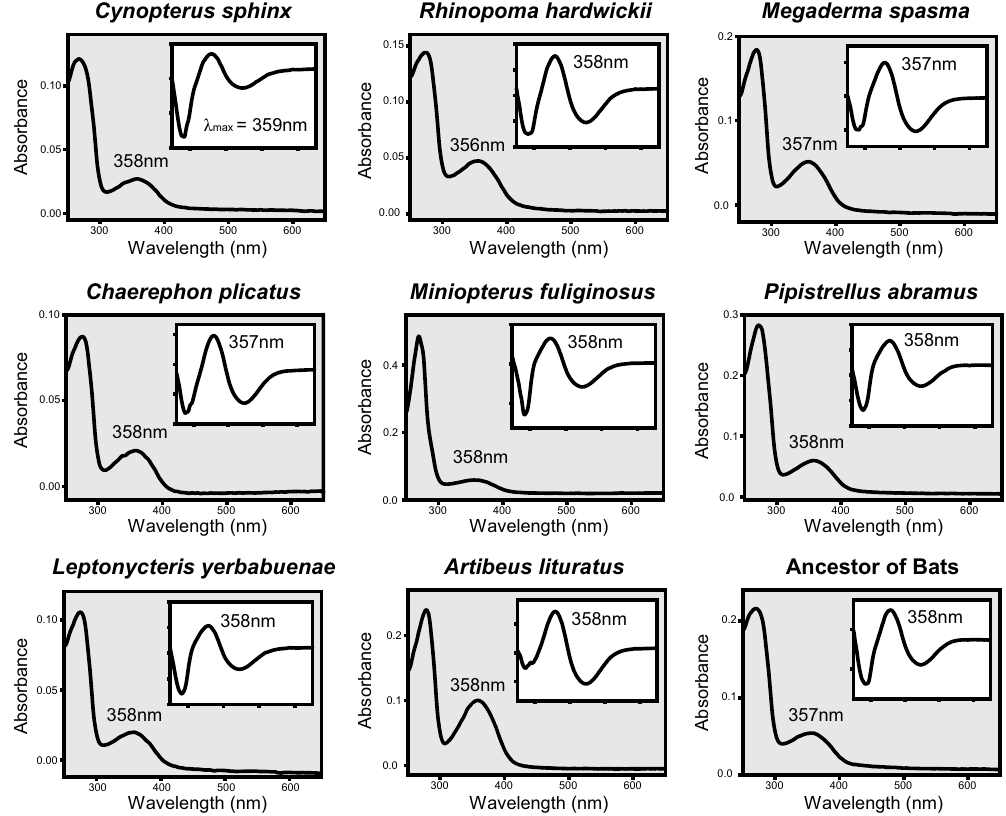
Figure 2. Spectral tuning of bat SWS1 pigments. Spectral sensitivities, with λ max values indicated, for SWS1 pigments from eight extant bat species and the resurrected bat ancestor are shown. The inset exhibits the dark minus acid difference spectrum for each